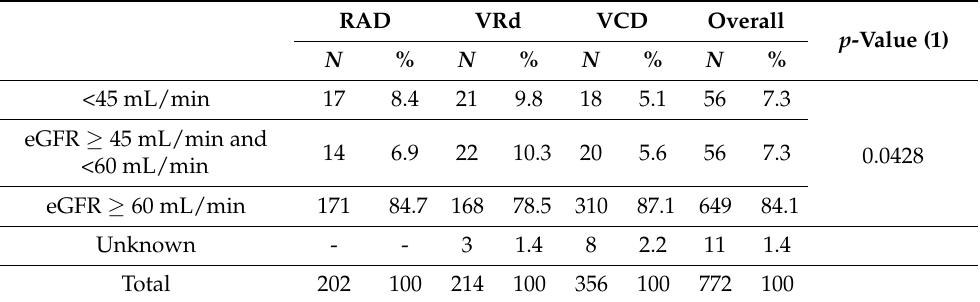
Table 4. Estimated glomerular filtration rate at screening in the categories (KDIGO 2012 criteria). Population: per-protocol set, N = 772.